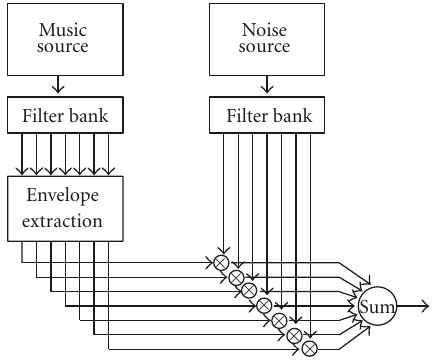
Figure 1: Modulating noise with the energy envelope of di ff erent bands from a filter bank retains the rhythmical content of the